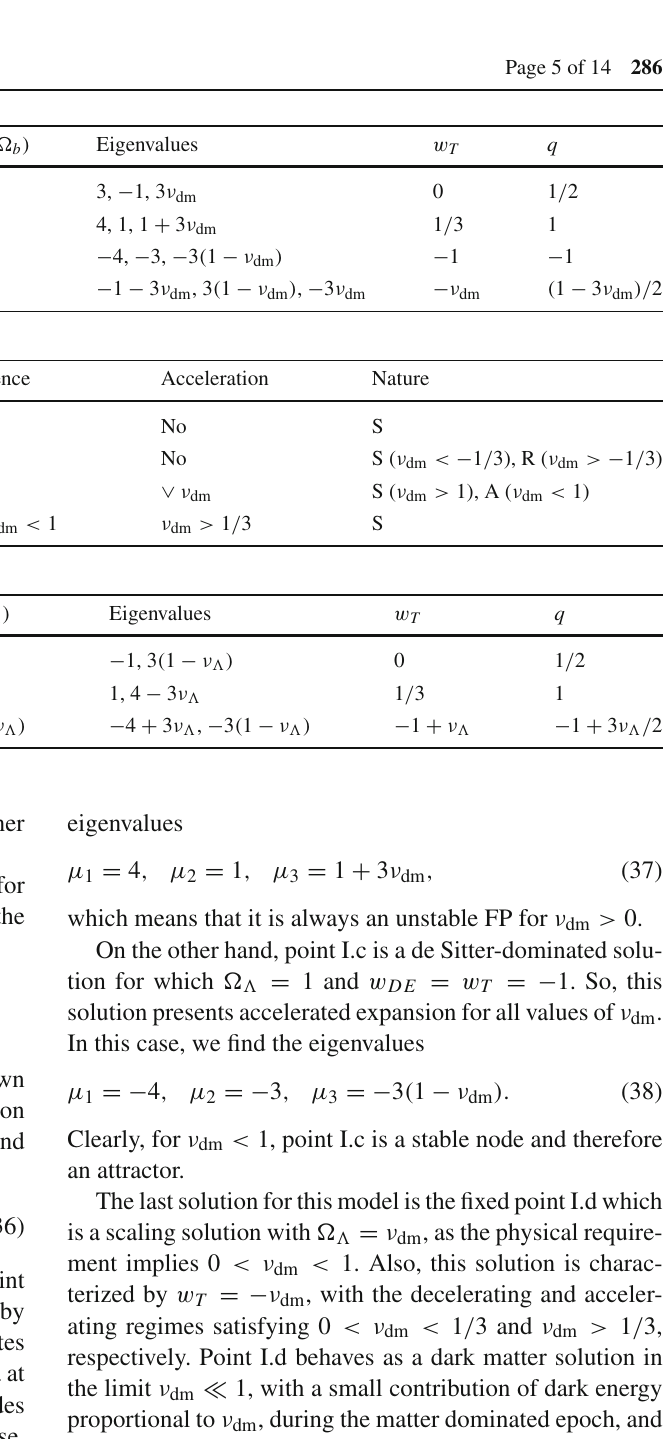
Table 4 Nature of fixed points of model II